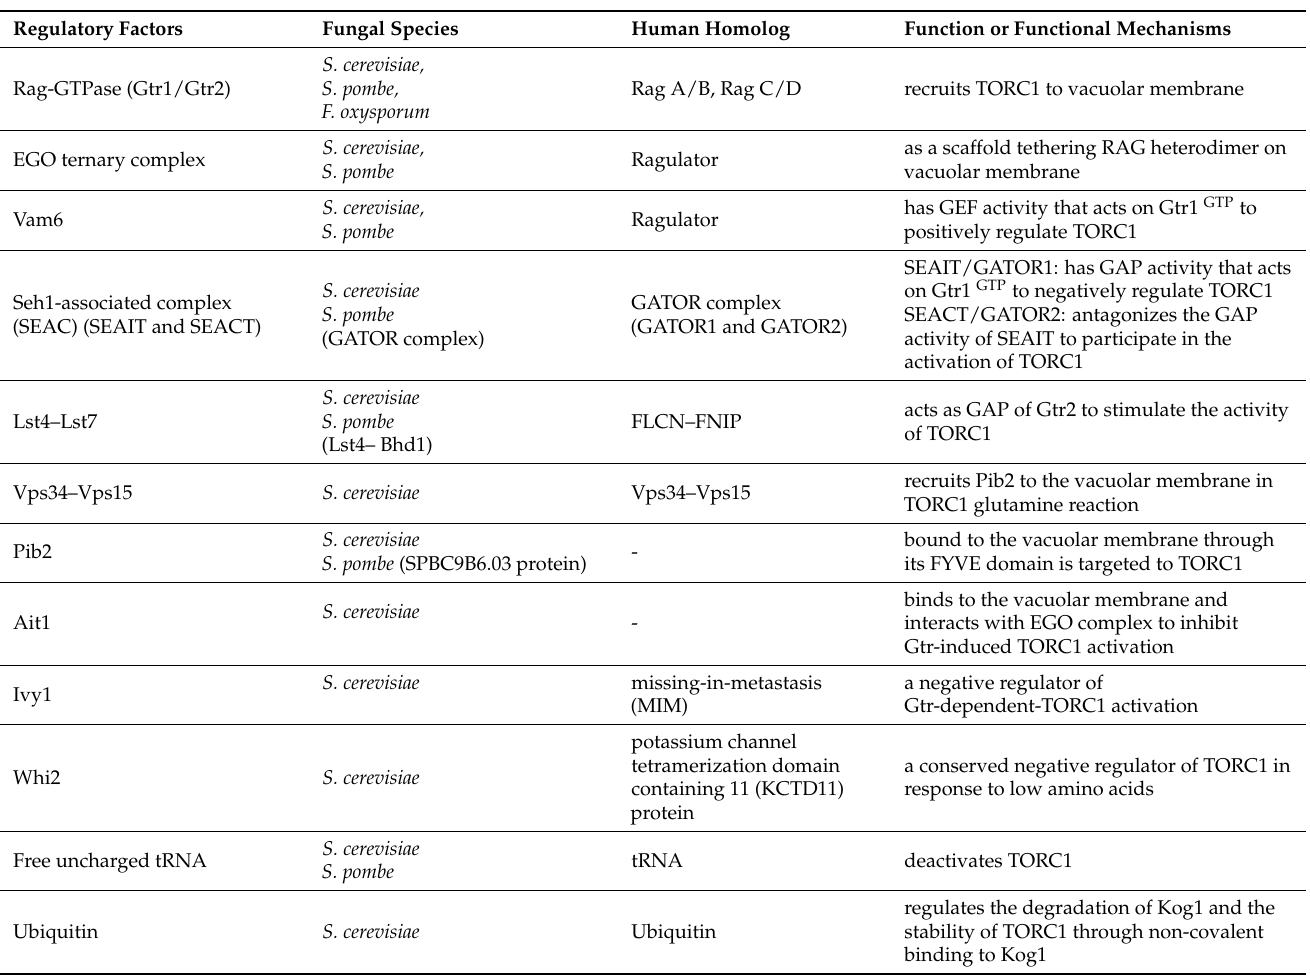
Table 1. The regulatory factors involved the operational mode of TORC1, their mammalian orthologs and functions or functional mechanisms in